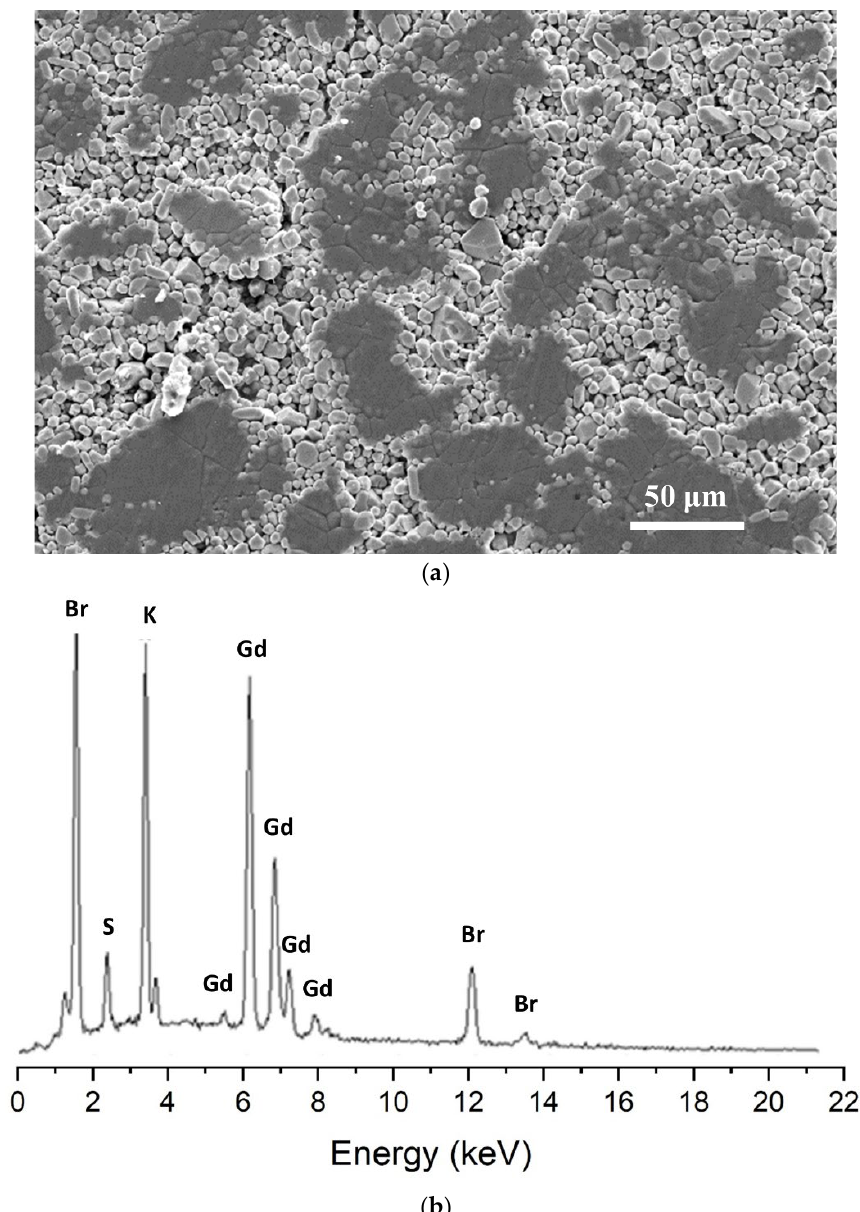
Figure 4. ( a ) SEM image of Gd 2 O 2 S screens showing the distribution of Gd 2 O 2 S (brighter regions) and KBr (darker regions) compounds. ( b ) EDS micro-analysis spectrum detecting main elements composing